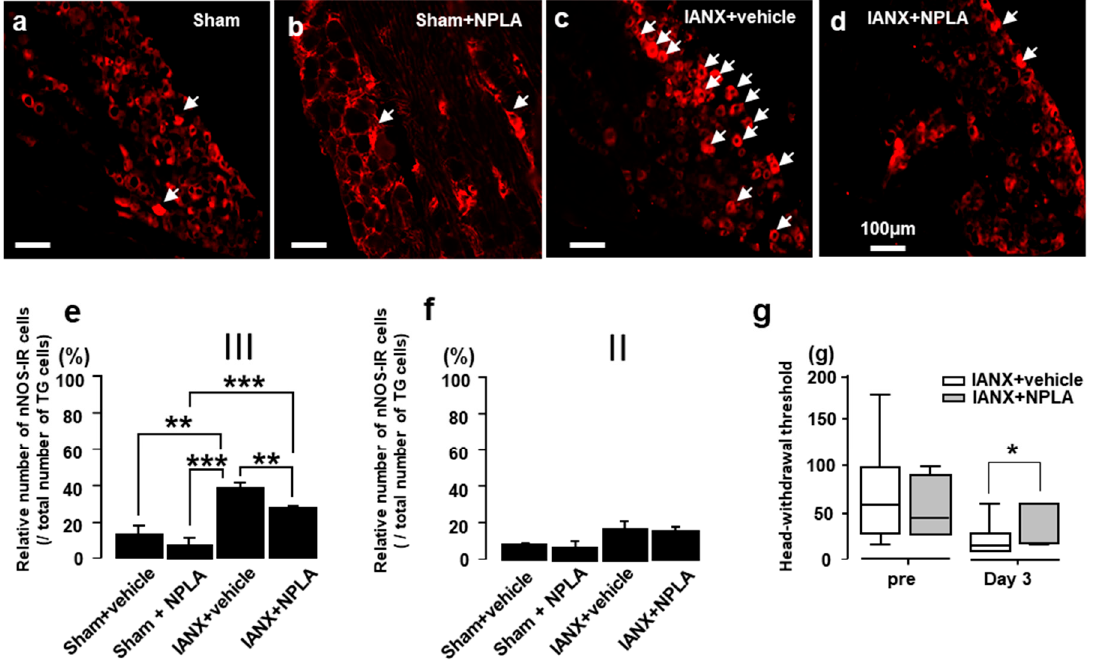
Figure 3. The effect of nNOS inhibitor (NPLA) administration on nNOS expression in the Ⅲ branch region of TG neurons in sham and IANX rats. ( a ): nNOS-IR cells in TG in sham, ( b ): sham+NPLA, ( c ): IANX+vehicle, ( d ): IANX+NPLA rats. ( e ): Relative number of nNOS-IR cells in the Ⅲ branch region of TG in sham, IANX+vehicle or IANX+NPLA rats. ( f ): Relative number of nNOS-IR cells in the Ⅱ branch of TG. ( g ): Effect of NPLA administration into TG on MHWT in IANX rats. The arrows indicate nNOS-IR cells. **: p < 0.01, ***: p < 0.001. n = 5 in each group ( e and f ). *: p < 0.05 (vehicle vs. NPLA). n = 7 in each group ( g ).